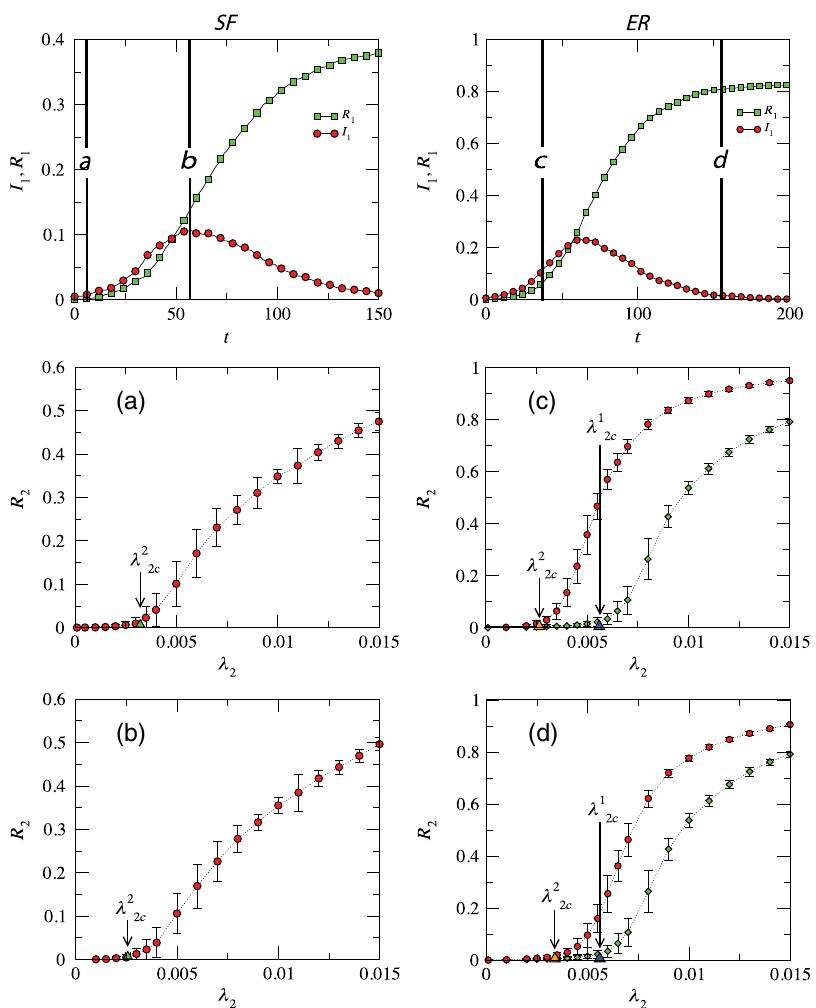
FIG. 8. Epidemic thresholds in the SIR-SIR interacting epidemic model. Upper panels: Temporal evolution of disease 1, in a scale-free (SF, left) and in an Erdos-Renyi (ER, right) network: I 1 ¼ RI RR t Þ . Disease 1 enhances the spreading of disease 2 in both cases, but still is not influenced by the second k;l þ k;l Þð infection. Lower panels: Total number of individuals affected by disease 2 as a function of λ 2 in each network: R ∞ 2 ¼ P P ð k; l Þð SR IR RR t Þ . Dynamical parameters: (a),(b) scale-free network: N ¼ 5000 , h k i ¼ 4 . 00 , h l i ¼ 5 . 11 , lim t → ∞ k;l þ k;l þ k;l Þð k;l